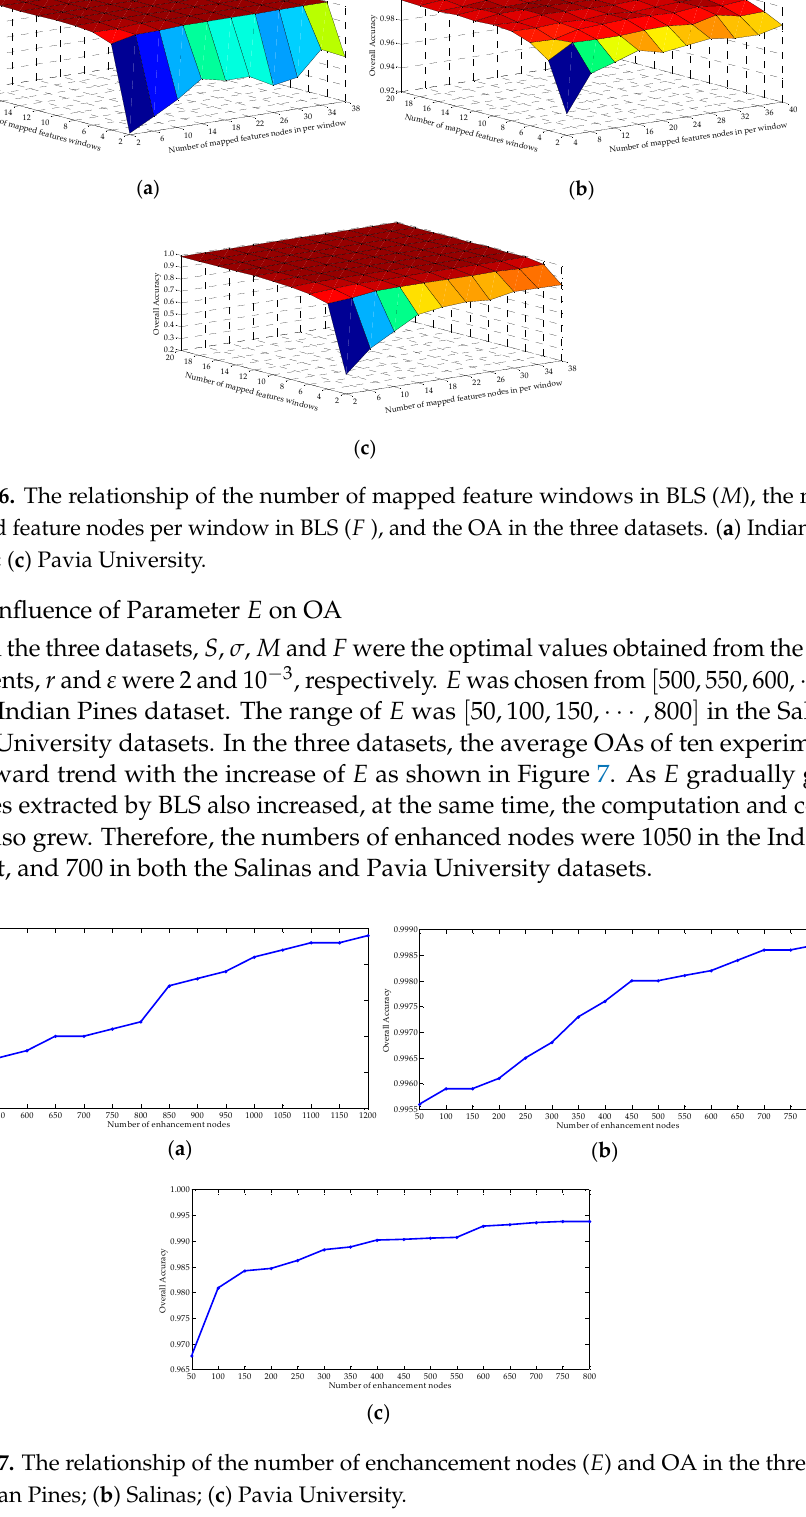
tasets. ( a ) Indian Pines; ( b ) Salinas; ( c ) Pavia University. ( a ) Indian Pines; ( b ) Salinas; ( c ) Pavia